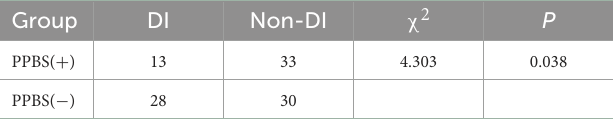
TABLE 1 Comparison of pituitary stalk diameter and length in 42 patients with pituitary adenoma before and after operation.